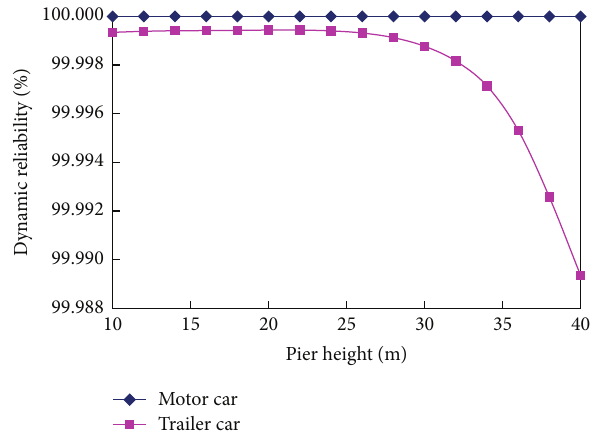
Figure 22: Dynamic reliability for wheel load decrement ratio with respect to pier